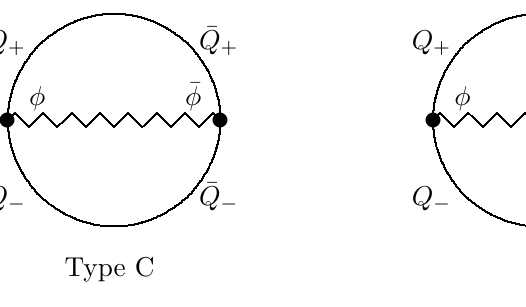
where " ABCD and " mnp are antisymmetric